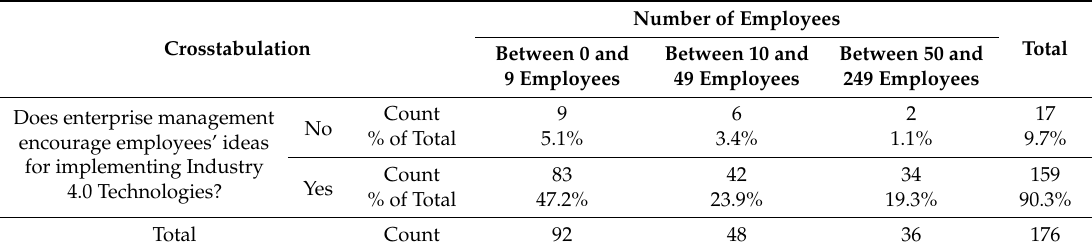
Table 11. The contingency table regarding the extent to which enterprise management encourages employees’ ideas to implement Industry 4.0 technologies in relation to enterprise